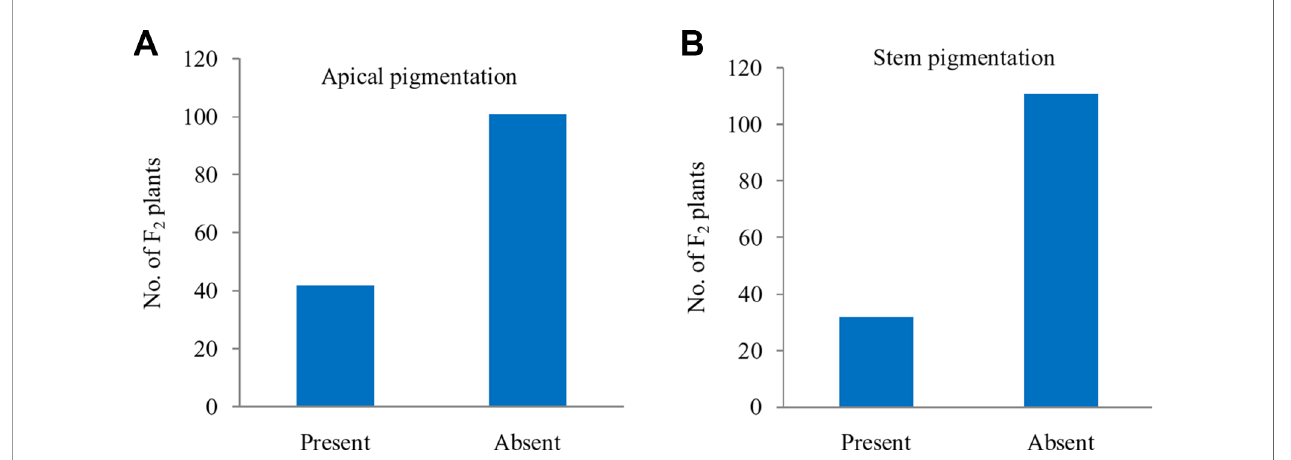
FIGURE 5 | Segregation of F 2 plants: apical pigmentation (A) and stem pigmentation (B) .